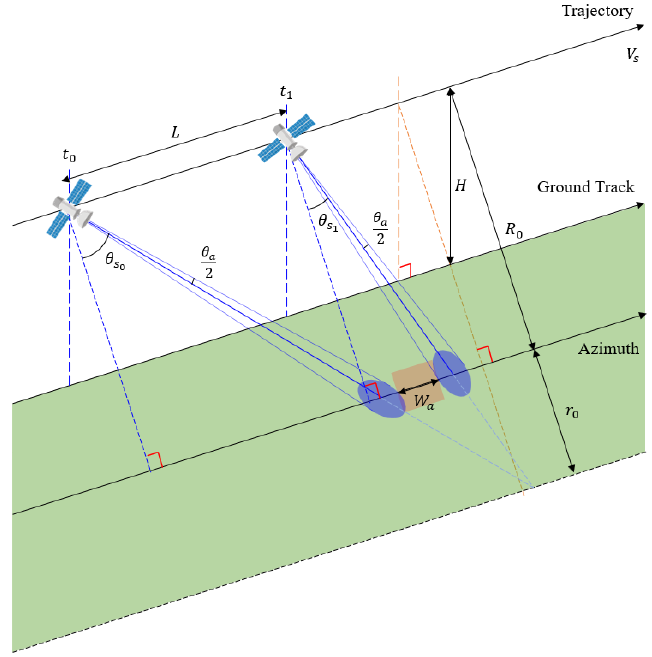
Figure 7. Illuminated geometry of squint sliding spotlight mode SAR.